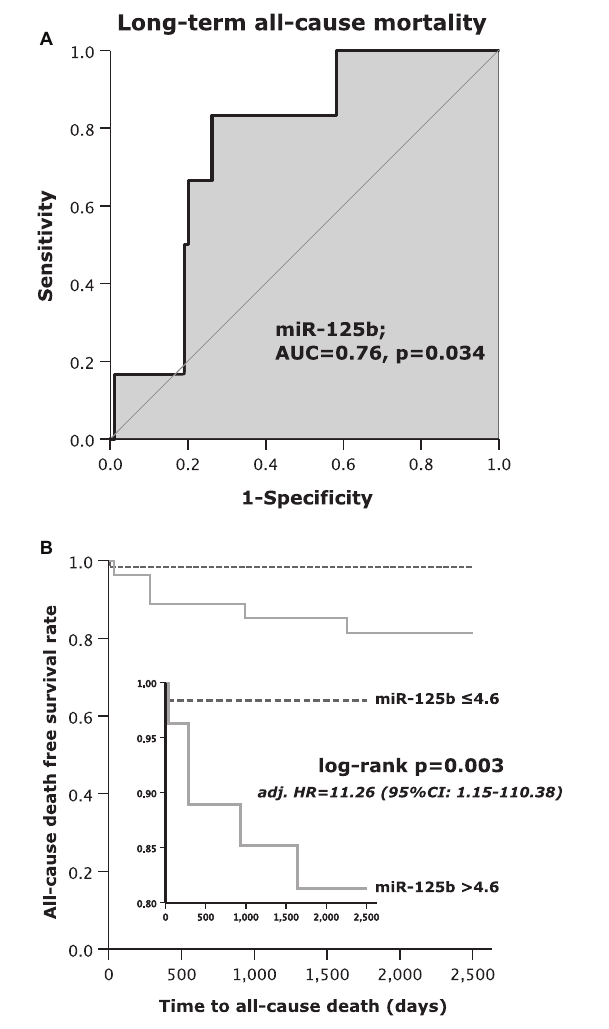
FIGURE 1 | (A) Receiver operating curve (ROC) analysis for microRNA (miR)-125b to predict long-term all-cause mortality and (B) Kaplan–Meier survival analysis for long-term all-cause mortality regarding high or low values of miR-125b.